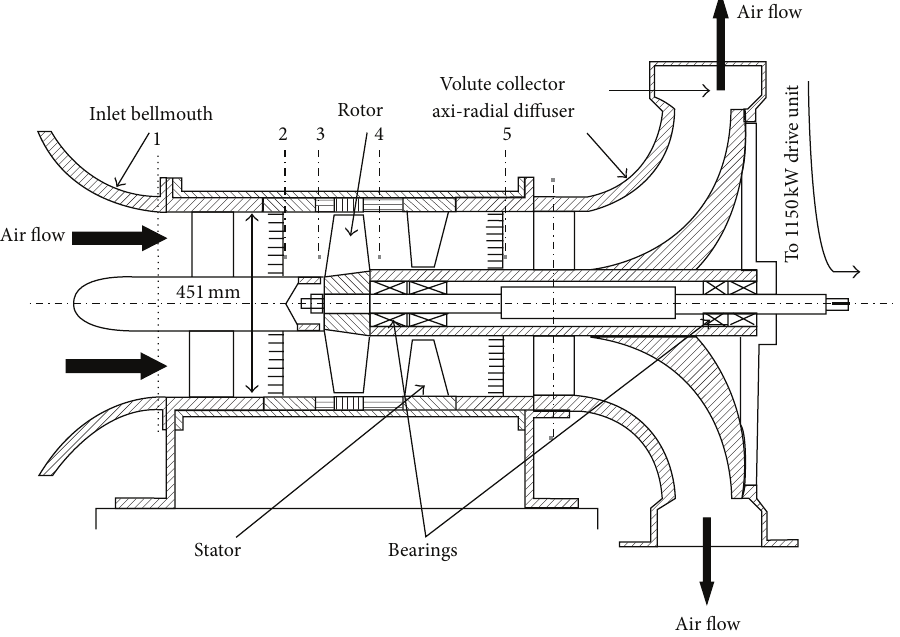
Figure 1: Schematic of the single stage transonic axial flow research compressor.